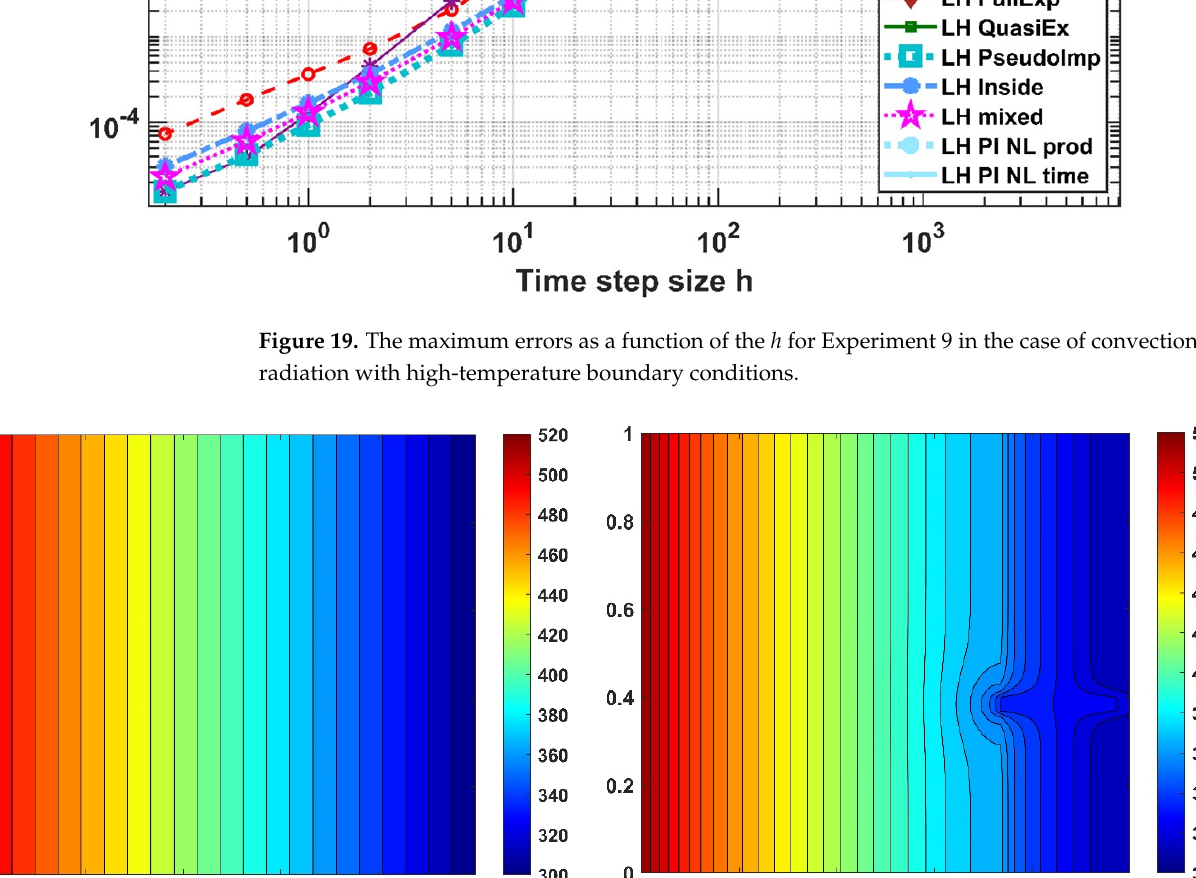
Figure 20. The distribution contour of the temperature in Kelvin units for the equidistant mesh at initial and final time (left and right figure, respectively), in the case of Experiment 9. The numbers on the axes are the coordinates in meter units.